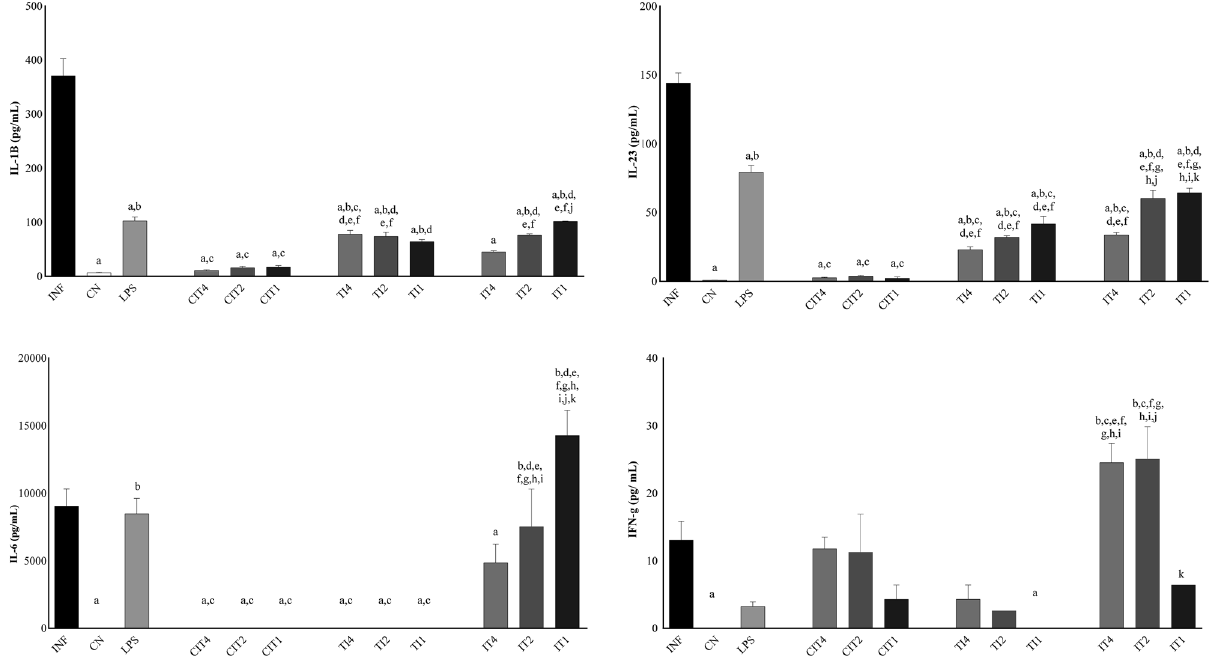
Figure 2. For analysis of cytokines IL-1β, IL-6, IL-23, and IFN-γ in human monocytes, the following groups were established: infected with isolate 80 (INF), negative control group (CN), groups treated with citral (CIT) at 4%, 2%, and 1% (CIT4, CIT2, and CIT1), groups treated with citral at 4%, 2%, and 1% and infected (TI4, TI2, and TI1), and infected and treated groups with citral at 4%, 2%, and 1% (IT4, IT2, and IT1). Treatment for 30 min and infection for 6 h. Statistically significant differences ( P < 0.05) compared to the INF control are indicated by letters: ( a ) compared to the negative control: ( b ) compared to LPS: ( c ) compared to CIT4: ( d ) compared to CIT2: ( e ) compared to CIT1: ( f ) compared to TI4: ( g ) compared to TI2: ( h ) compared to TI1: ( i ) compared to IT4: ( j ) compared to IT2: ( k ) Statistical significance (Mann–Whitney one-tailed; GraphPad Prism,